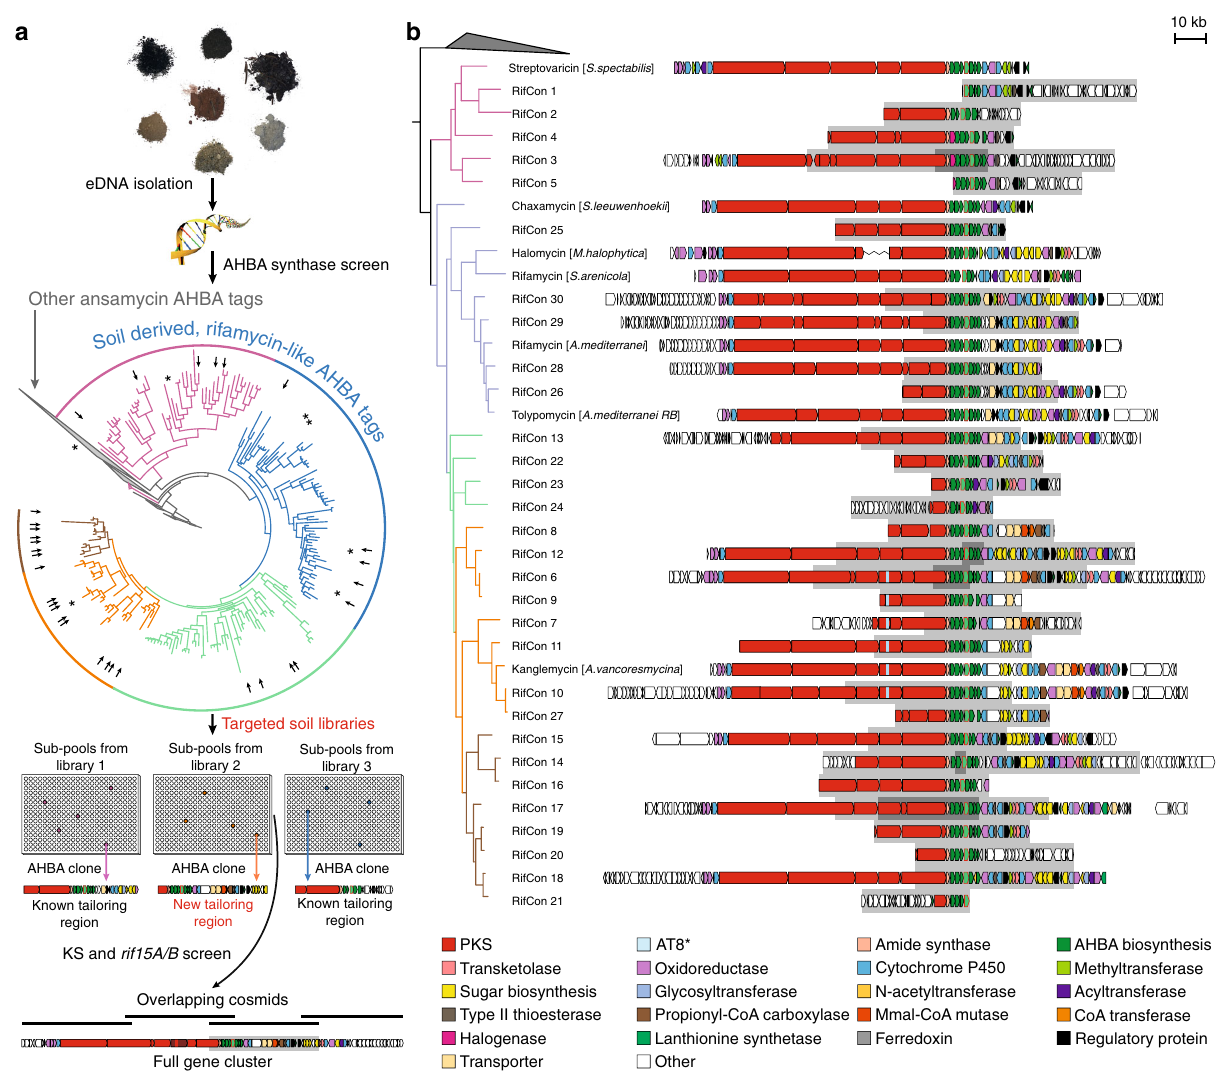
Fig. 2 Sequence-based screen for rifamycin congener gene clusters. a Screening overview. DNA isolated from ~1500 soils was screened for the presence of AHBA synthase genes by PCR using degenerate primers. Sequence tags generated in this screen were used to construct a phylogenetic tree, onto which AHBA synthase reference sequences from known rifamycin congener gene clusters were mapped (marked with asterisks). Large, distinct clades in the phylogenetic tree are shown in different colors. Metagenomic DNA cosmid libraries were generated from soils that contained AHBA sequence tags that spanned all AHBA clades predicted to be associated with rifamycin congener gene clusters. To facilitate the recovery of individual clones containing gene clusters of interest, each metagenomic library was expanded to contain >20,000,000 unique eDNA cosmids and formatted as smaller subpools of between 20,000 and 60,000 unique cosmid clones per sub-pool. Primary clones (those containing an AHBA synthase gene) were recovered from AHBA positive subpools using a PCR dilution method and degenerate AHBA synthase primers. The same approach, but with degenerate primers targeting PKS ketosynthase (KS) domains and the rif15A/15B tailoring genes, was used to recover regions of the pathways that fl ank those found on the primary clone. AHBA sequence tags corresponding with primary clones that were targeted for recovery are indicated with arrows on the phylogenetic tree. b Summary of rifamycin congener gene clusters recovered from the soil metagenomes. Portions of the gene clusters found on primary clones are shown on a